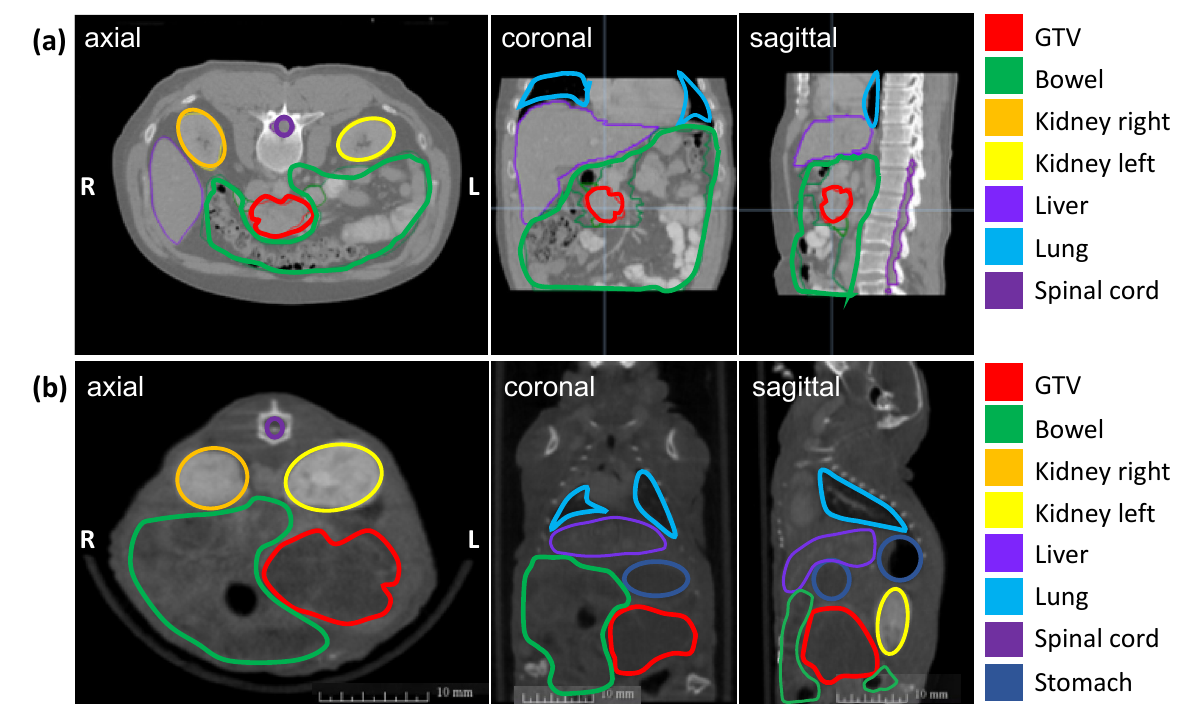
Figure 1. Planning imaging and contouring of the GTV (pancreatic tumor in red) and OARs (bowel in green, left kidney in orange, right kidney in yellow, the liver in lavender, lung in light blue, spinal cord in purple, and stomach in dark blue) in three different planes (axial, coronal, sagittal). ( a ) Planning CT images of a representative patient with PDAC; ( b ) Planning CBCT images of a representative mouse with an orthotopic pancreatic tumor.